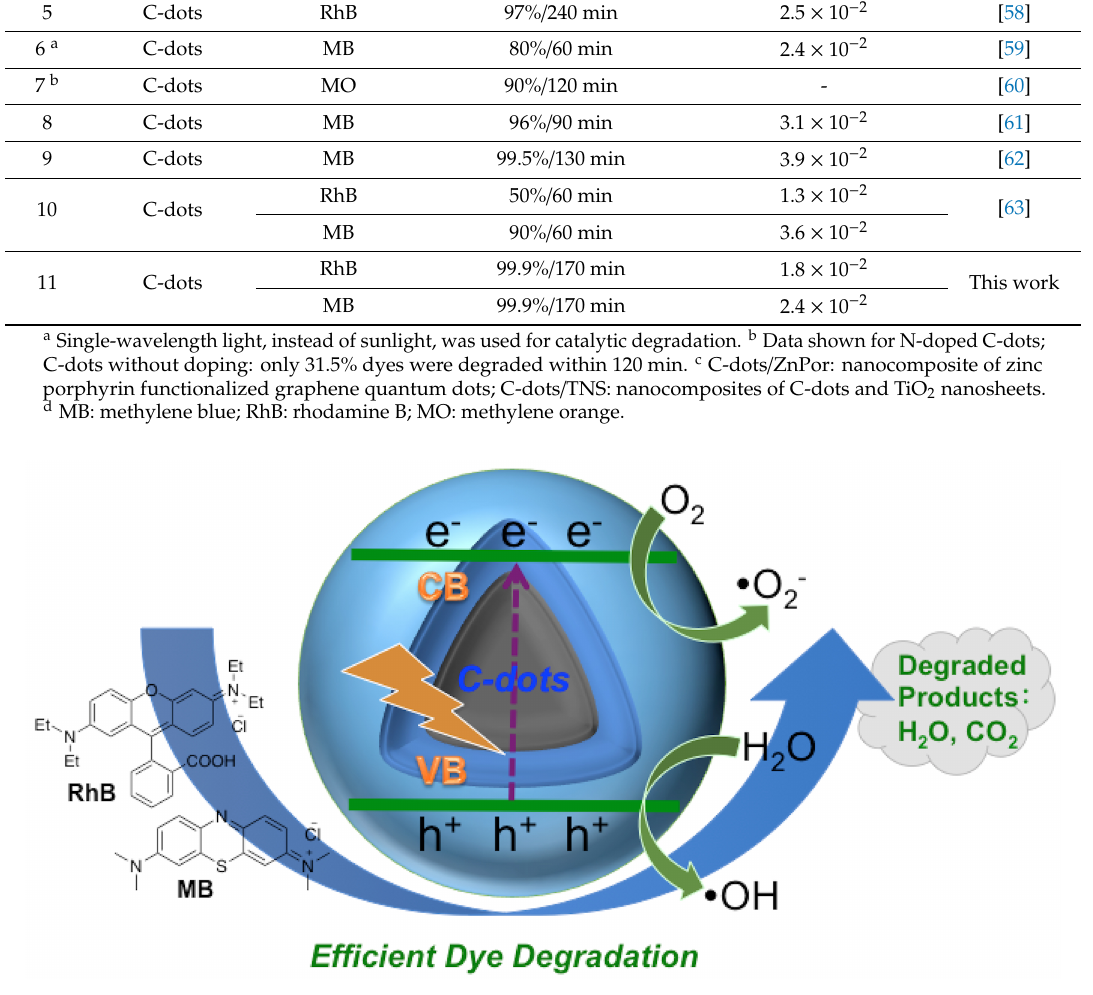
Figure 5. A plausible mechanism of the photocatalytic degradation of RhB and MB catalyzed by “B-doped” C-dots.